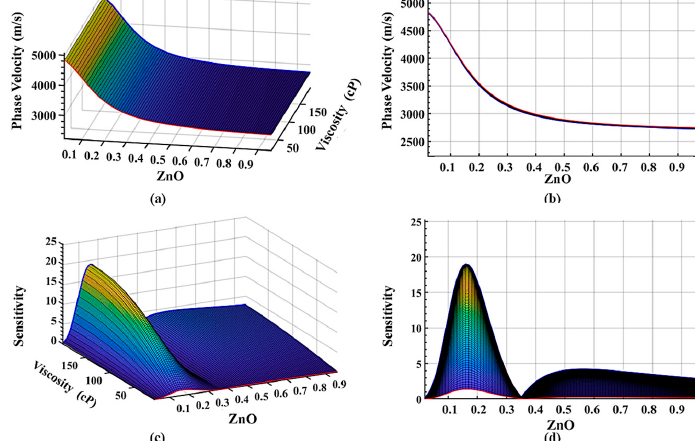
Figure 5. Dispersion surface plots of the four-layer system with varying viscosity of liquid layer at 100 MHz with relaxation time, ωτ = 10. The thickness of the second guided layer IrO 2 is set to 35 nm, and the thickness of the liquid is chosen to be 0.1 µm. ( a ) Isometric view of the phase velocity dispersion with varying viscosity of the liquid layer; ( b ) phase velocity vs. views normal to ZnO layer thickness variation; ( c ) isometric view of the mass sensitivity (unit: m 2 /kg) dispersion with variation viscosity of the liquid layer; ( d ) sensitivity (unit: m 2 /kg) vs. view normal to ZnO layer thickness variation.